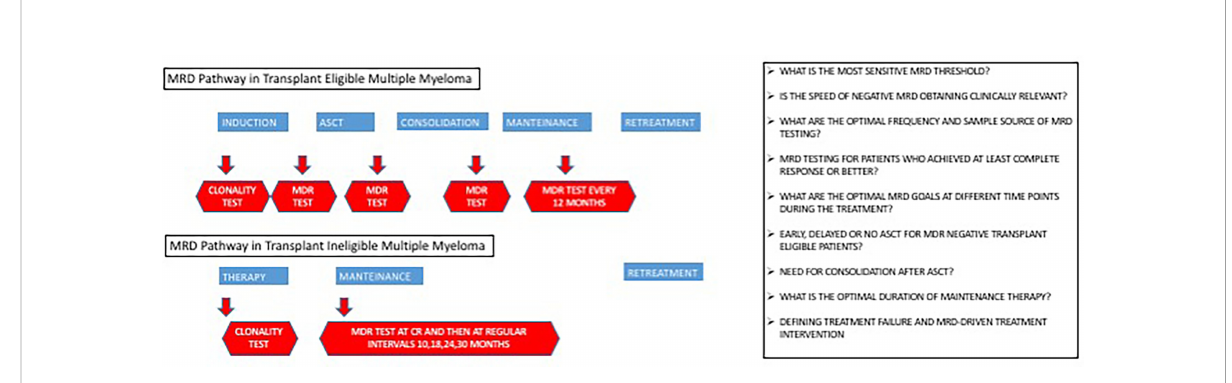
FIGURE 2 Future minimal residual disease (MRD) prospects in a multiple myeloma clinical